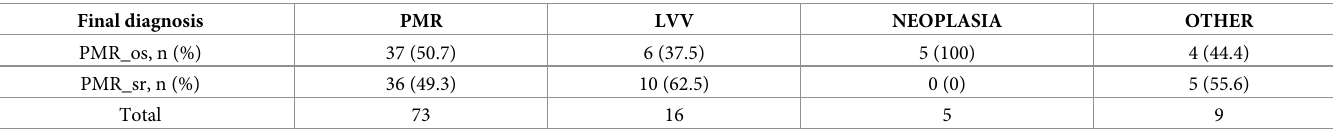
clear increased risk of cancer within the first year of PMR diagnosis. Similarly, Muller et al. Table 5. Final diagnosis of patients with onset PMR (PMR_os) vs steroid resistant